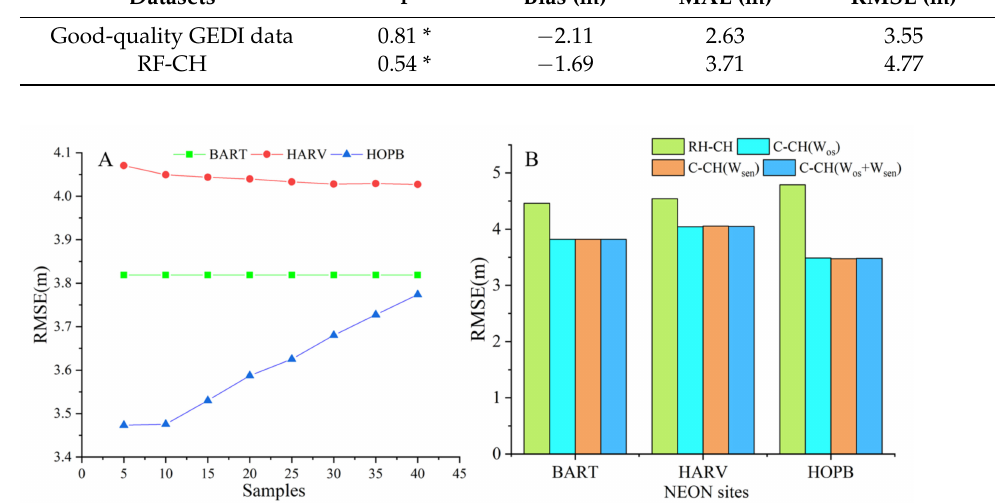
Figure 10. Performance of the FPSF-CH using a different number of good-quality GEDI observations ( A ) and weighting strategies ( B ) for calibration. The W os and W sen represent weights indicated by the DI difference between an object pixel in RF-CH and the corresponding GEDI data and waveform sensitivity,